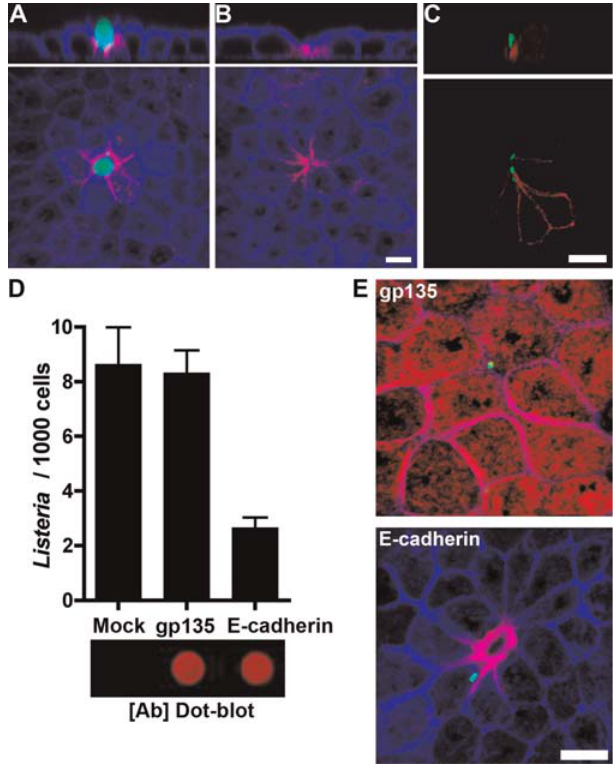
Figure 6. L. monocytogenes Attachment to Accessible E-cadherin at Multicellular Junctions of Cell Extrusion Sites (A and B) Polarized MDCK monolayers on Transwell filters were incubated with Sytox green prior to fixation. Monolayers were left unpermeabilized and stained from the apical side with an antibody to the extracellular domain of E-cadherin (red) and with phalloidin to visualize the F-actin cytoskeleton (blue). (A) A site with a cell in the process of extrusion. (B) A site where extrusion has been completed. (C) Polarized MDCK monolayers on Transwell filters were infected from the apical side with L. monocytogenes for 10 min, then stained from the apical side with antibodies to L. monocytogenes (green) and E-cadherin (red) without permeabilizing the sample. (D) Polarized MDCK monolayers on Transwell filters were pretreated with anti-gp135 or anti–E-cadherin antibodies, then infected with L. mono- cytogenes for 5 min. Means and standard deviations of the number of L. monocytogenes adhered per 1,000 cells from triplicate samples are shown. The E-cadherin antibody–treated sample group is significantly different: one-way analysis of variance p ¼ 0.0004. Bonferroni t- test Mock versus gp135 p . 0.05; Mock or gp135 versus E-cadherin p , 0.001. Shown below the bar graph, blocking antibody concentrations were normalized using a fluorescence-based dot-blot analysis ([Ab] Dot-blot). (E) Confocal immunofluorescence images show the localization of the blocking antibodies (red), adhered L. monocytogenes (green) and the F- actin cytoskeleton (blue). Scale bars 10 l